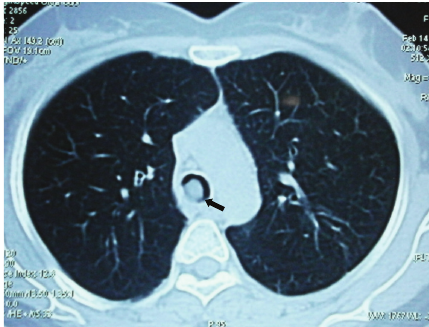
Figure 1: CT scan of the thorax showing a endoluminal polypoidal growth (arrow) arising from the posterior wall of the tracheal